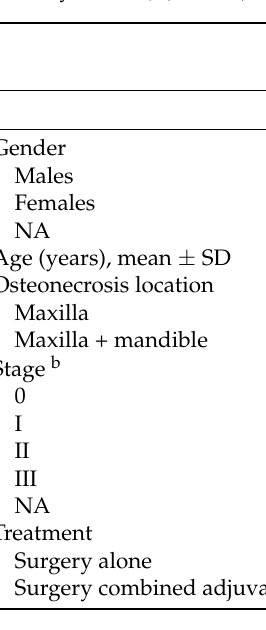
Table 1. Demographic characteristics and clinical factors from consolidated analysis of patients with maxillary MRONJ ( n =